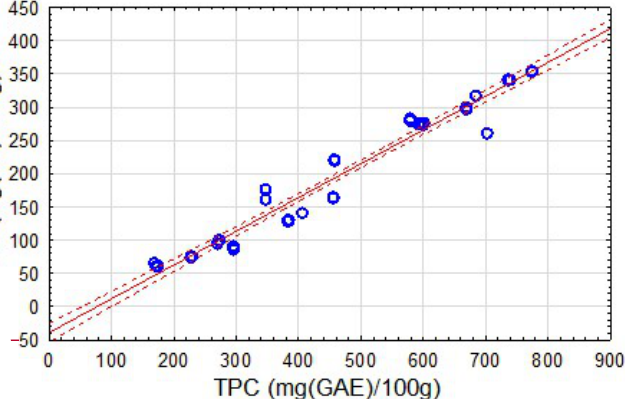
Figure 3. The correlation between TPC and antioxidant capacity with correlation coefficient R = 0.9798.